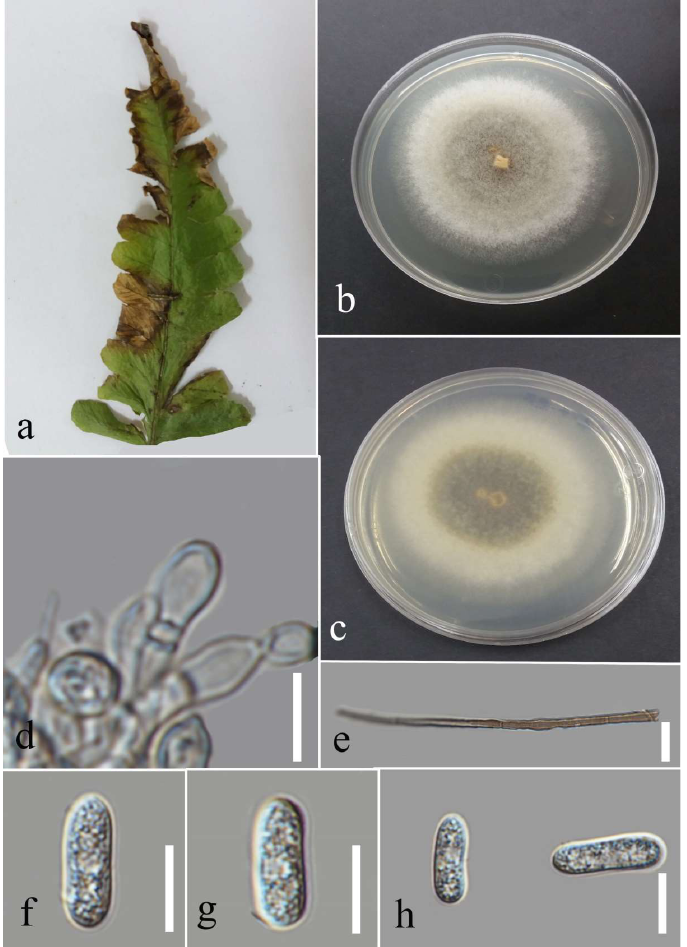
Figure 29. Morphology of Colletotrichum orchidearum (MFLUCC 22-0152): ( a ) necrotic lesion on Cyclosorus sp.; ( b – c ) upper and reverse views of the colony after seven days of growth on PDA at 28 ◦ C; ( d ) conidiogenous cells; ( e ) satae; ( f – h ) conidia. Scale bars ( e ) = 20 µ m and ( d , f – h ) = 10 µ m. Colletotrichum plurivorum Damm, Alizadeh & Toy. Sato, 2018; Figure 30. Associated with Cyclosorus sp. leaf necrotic lesions. Sexual morph: formed on PDA containing tooth pick at room temperature after two months, ascomata, perithecia ag- gregated, semi-immersed, globes, and covered with sparse white aerial mycelia. Asci cylindrical to clavate, hyaline, unitunicate, eight ascospores, and 67–86 × 10–12 µ m. As- cospores allantoid to fusiform, initially hyaline, aseptate, rounded tips, and 12–31 µ m (mean = 18.2, n = 30) × 4–8 µ m (mean = 5.5, n = 30). Asexual morph: conidiomata acervulus. Setae absent. conidiophores reduced to conidiogenous cells. Conidiogenous cells cylindrical and hyaline. Conidia cylindrical, hyaline, aseptate with rounded apices, and 10–21 µ m (mean = 16.3, n = 30) × 3–6 µ (mean = 4.7, n = 30). Appressoria diverse shape, bullet-shaped to lobate, brown, regular or irregular margin, and 7–13 µ m (mean = 9.5, n = 20) × 4–8 (mean = 6.2, n = 20). Culture characteristics: Colonies filled the 90 mm Petri dish after seven days of growth on PDA at 28 ◦ C; fluffy to cotton, circular shape, dull surface, entire edge, with fluffy margin and medium density, without pigmentation in media and conidial mass. Upper view circles of smoke gray and white and the reverse circles of greenish olivaceous and primrose with greenish olivaceous